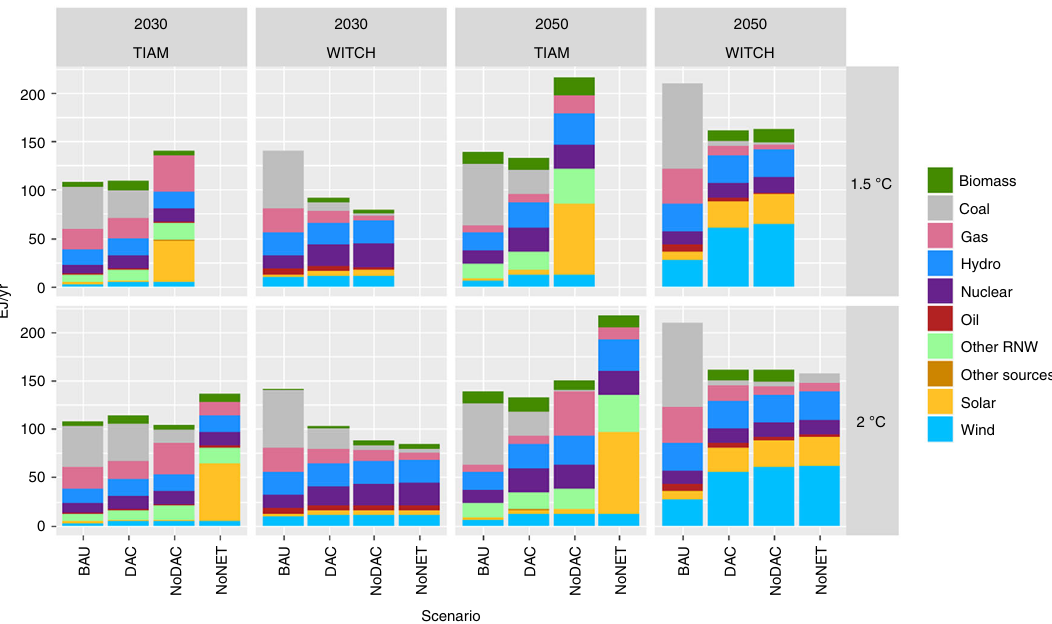
Fig. 3 Electricity mix in 2030 and 2050 in central case scenarios, compared to the Business-As-Usual (BAU). BAU assumes no mitigation policy to be implemented from 2020 on: economic and population growth are calibrated according to Shared Socio-Economic Pathways 2 in both models